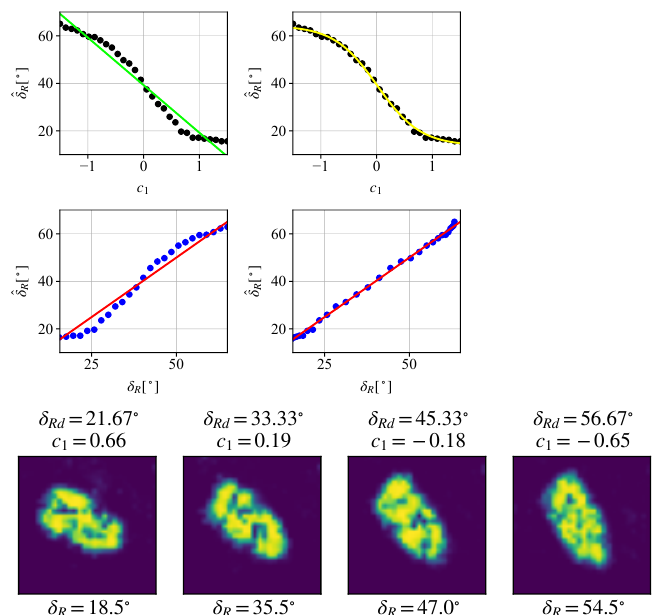
Figure 7. The results for the estimated and modeled rotation angle for the SAR images synthesized by the InfoGAN trained with simulated SAR images. The rotation angles in SAR images as a function of the latent code, c 1 , measured by cross-correlation (black dots) and the estimated values with a linear model (green line) ( top-left ). The rotation angles in SAR images as a function of the latent code, c 1 , measured by cross-correlation (black dots) and the estimated values with a nonlinear model (yellow line) ( top-right ). Comparison of the measured angle values by cross-correlation with the ones obtained using the linear model (blue dots), where the red line denotes the ideal case that ˆ δ ( k ) = δ ( k ) for all k ( middle-left ). Comparison of the estimated angle values with the ones R R obtained using the nonlinear model (blue dots) ( middle-right ). The synthesized SAR images using c 1 calculated by (26) for four desired rotation angles, δ Rd = 21.67 ◦ , 33.33 ◦ , 45.33 ◦ , 56.67 ◦ ( bottom row ). The estimated rotations of the synthesized SAR images, δ R ( k ) are calculated using (19). They are close to the desired